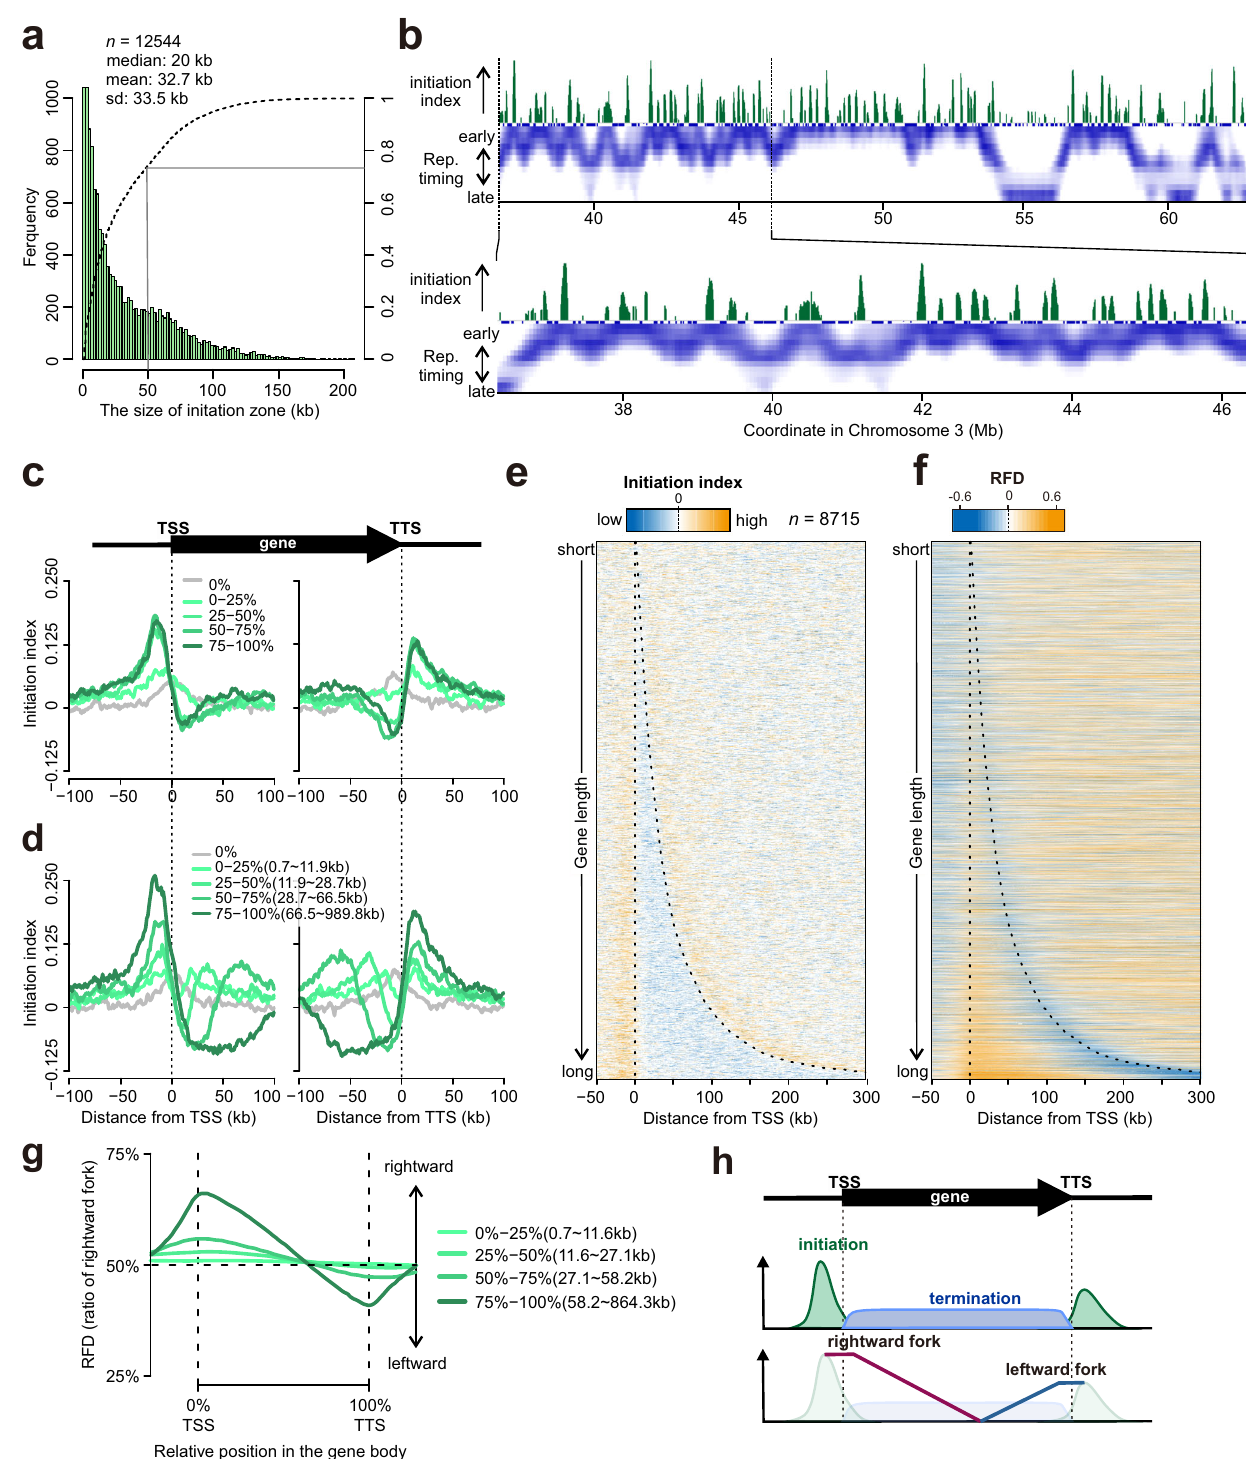
Fig. 3 | Genomic distribution of initiation sites. a Distribution of initiation zone widths. b High-resolution replication timing data and initiation index plotted for a representative region of chromosome 3. The pro fi le of replication timing for HCT116 cells is from Zao et al. 24 . c , d Average initiation index ±100kb around annotatedTSSandTTSinthehumangenome.Initiationindexdataarecategorised by transcriptional activity (c) or gene length (d). For the gene length analysis only the 50% most transcriptionally active genes were included. e Heat map repre- sentation of data in panel d sorted by gene length. Broken lines indicate the